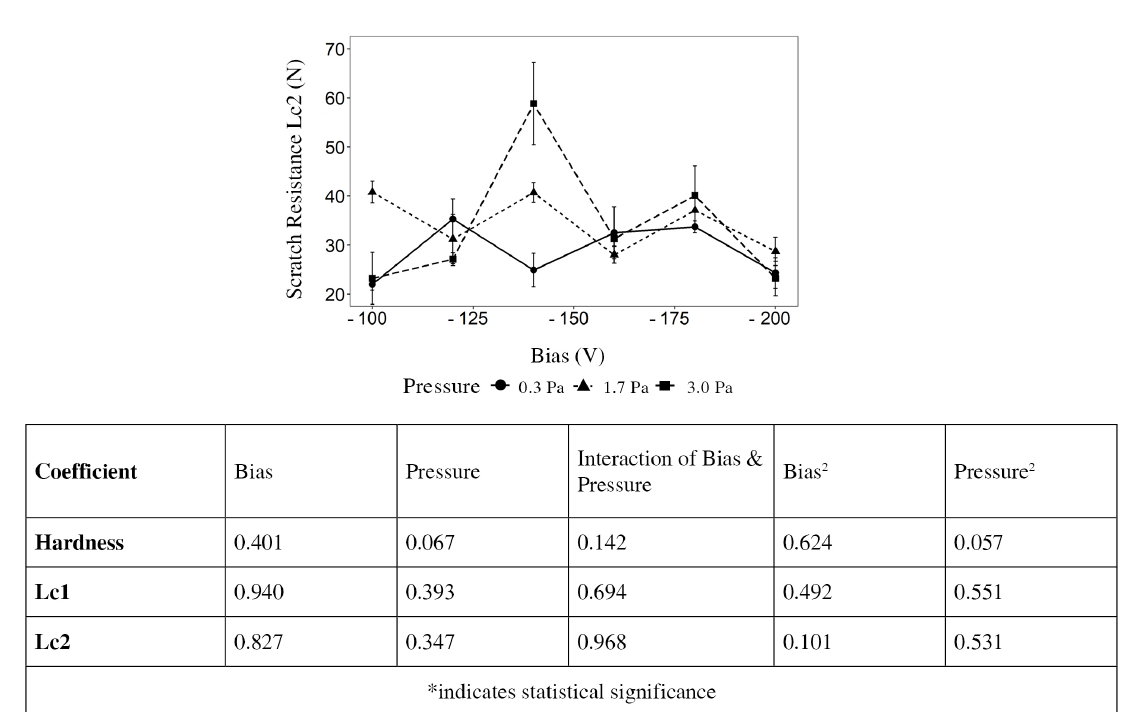
Figure 11. Scatter plot of the hardness and scratch resistance (Lc1 and Lc2).